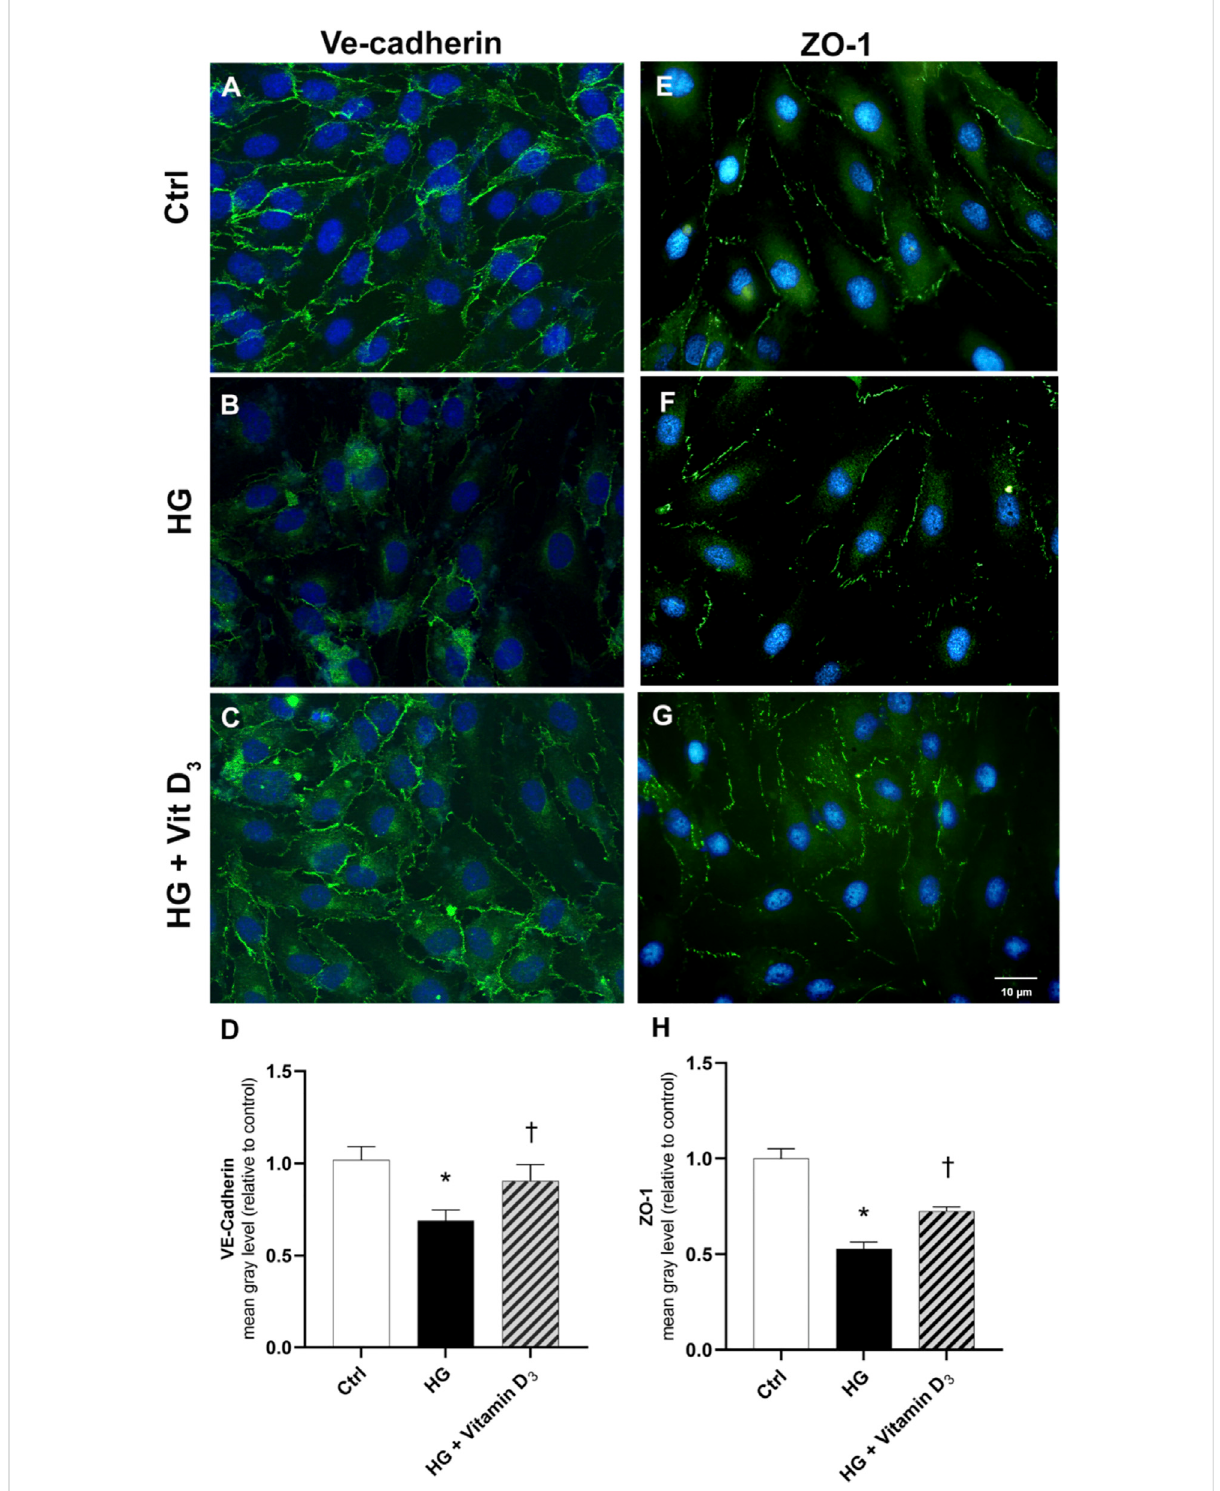
FIGURE 3 Vitamin D 3 re-establishes iBRB integrity through modulation of VE-cadherin and ZO-1. HRECs were pretreated with vitamin D 3 (1 μ M) for 24 h and subsequently co-treated with HG (40 mM) for other 48 h. Vitamin D 3 increased the expression of VE-cadherin and ZO-1 proteins, which were signi fi cantly reduced by HG. Representative images for VE-cadherin (A,B,C) and ZO-1 (E,F,G) expression in HRECs after treatment with HG and vitamin D 3 . VE-cadherin and ZO-1 were labeled with FITC (green); nuclei were labeled with DAPI (blue). Images were acquired at × 40 magni fi cation.Scalebar:10 µm.Fluorescencesemi-quanti fi cationofVE-cadherin (D) andZO-1 (H)